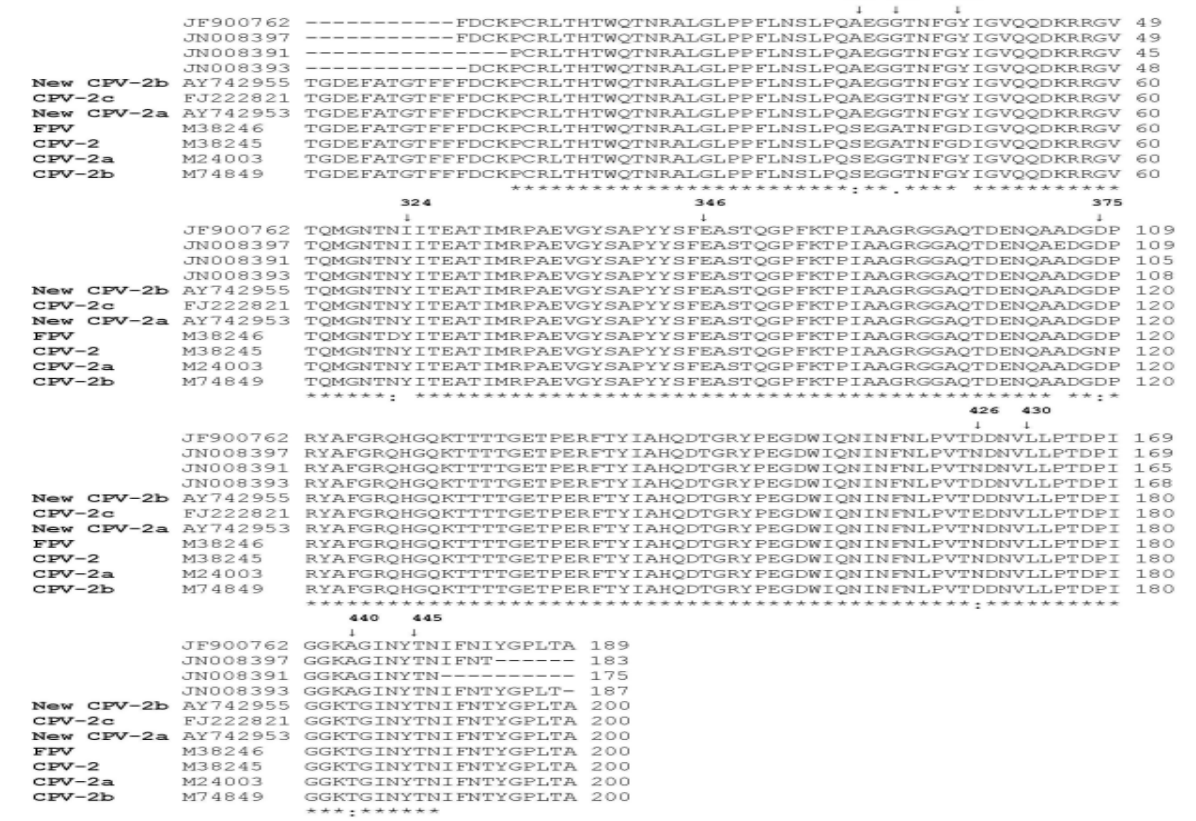
Figure-1 . Alignment of the deduced amino acid sequences of partial VP2 gene. Sequence of the representative canine parvovirus field isolate/sample JN008391, JN008395 (New CPV 2a), JN008393, JF900762 (New CPV-2b) is shown aligned with the reference strains M38246 (FPV), M38245 (CPV-2), M24003 (CPV-2a), M74849 (CPV-2b), AY742953 (New CPV-2a), AY742955 (New CPV-2b) and FJ222821 (CPV-2c) obtained from the